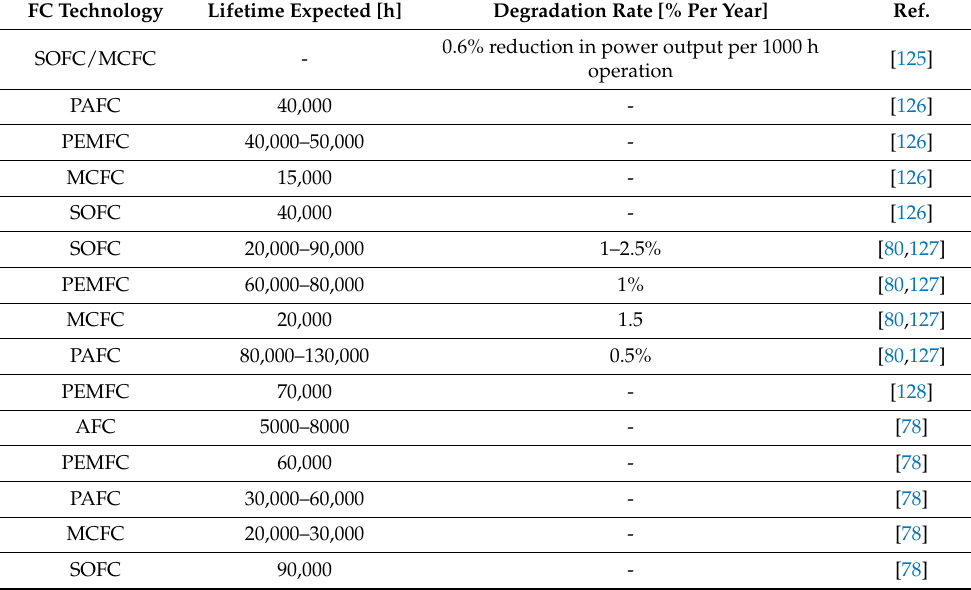
Table 7. Fuel Cell Maintenance and Lifetime Expected.